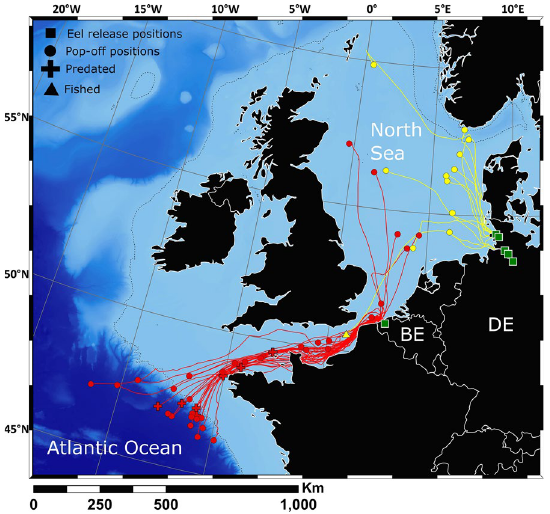
Figure 2. The reconstructed migration routes of the 42 Belgian (red) and 12 German eels (yellow). Predation is indicated by a cross and the fished eel in the English Channel by a triangle. Other premature and programmed pop-offs are shown with a circle. The eel release positions are indicated with a green square. The 200-m depth contour is delineated with a dotted line. The map was generated with ArcGIS 24